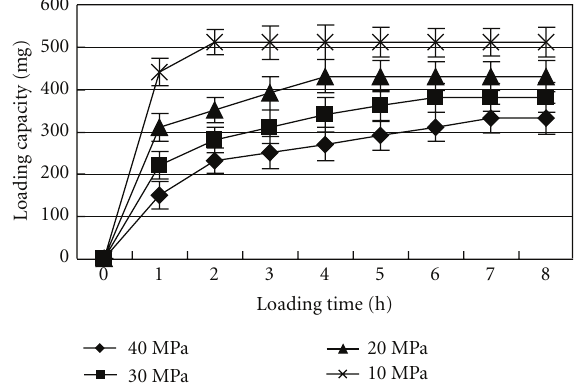
Figure 1: Correlation between SEDDS loading and loading